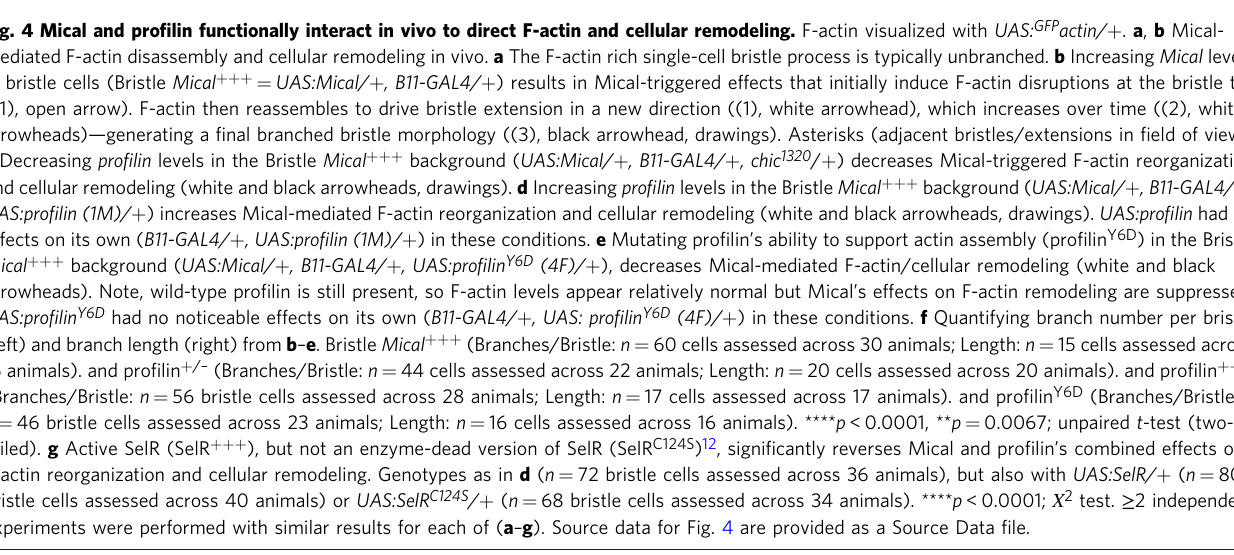
Fig. 4 Mical and pro fi lin functionally interact in vivo to direct F-actin and cellular remodeling. F-actin visualized with UAS: GFP actin/ + . a , b Mical- mediated F-actin disassembly and cellular remodeling in vivo. a The F-actin rich single-cell bristle process is typically unbranched. b Increasing Mical levels in bristle cells (Bristle Mical +++ = UAS:Mical/ + , B11-GAL4/ + ) results in Mical-triggered effects that initially induce F-actin disruptions at the bristle